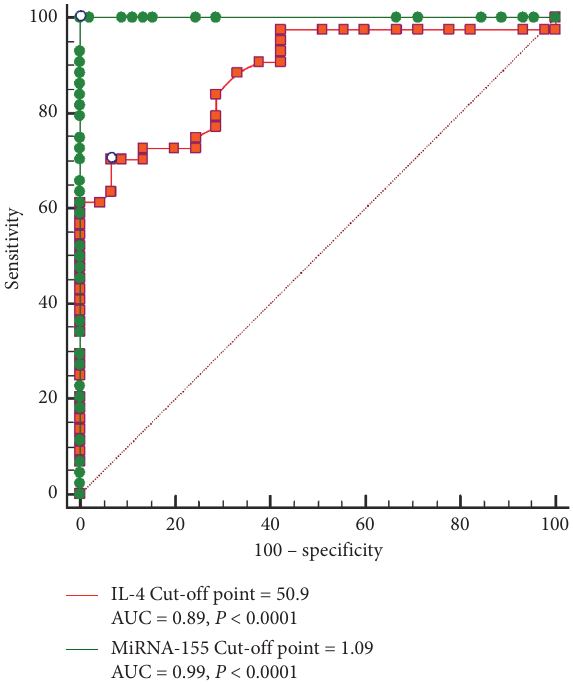
Figure 2: ROC curve showing the performance of miRNA-155 and IL-4 in the diagnosis of allergic